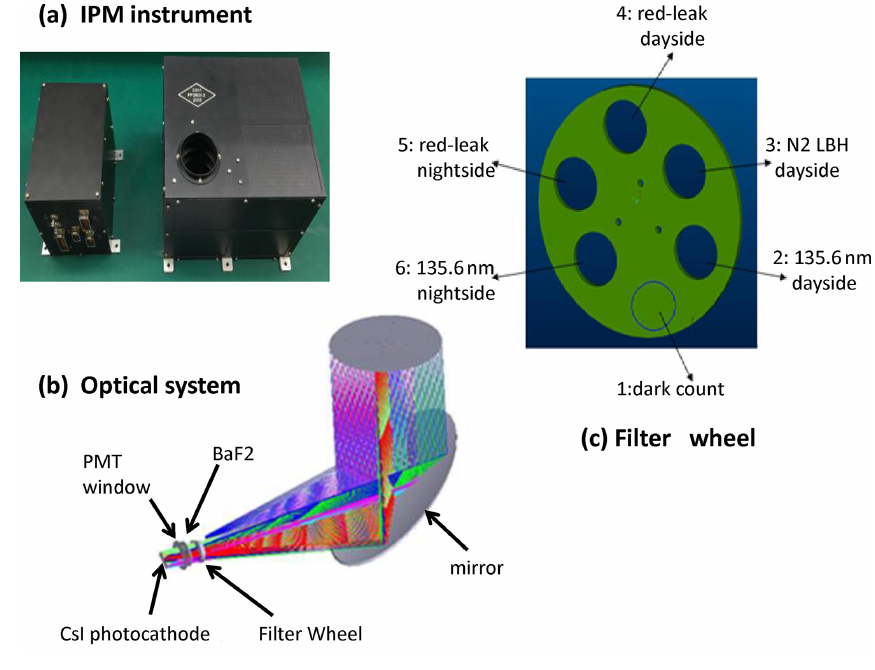
Figure 1. IPM instrument.